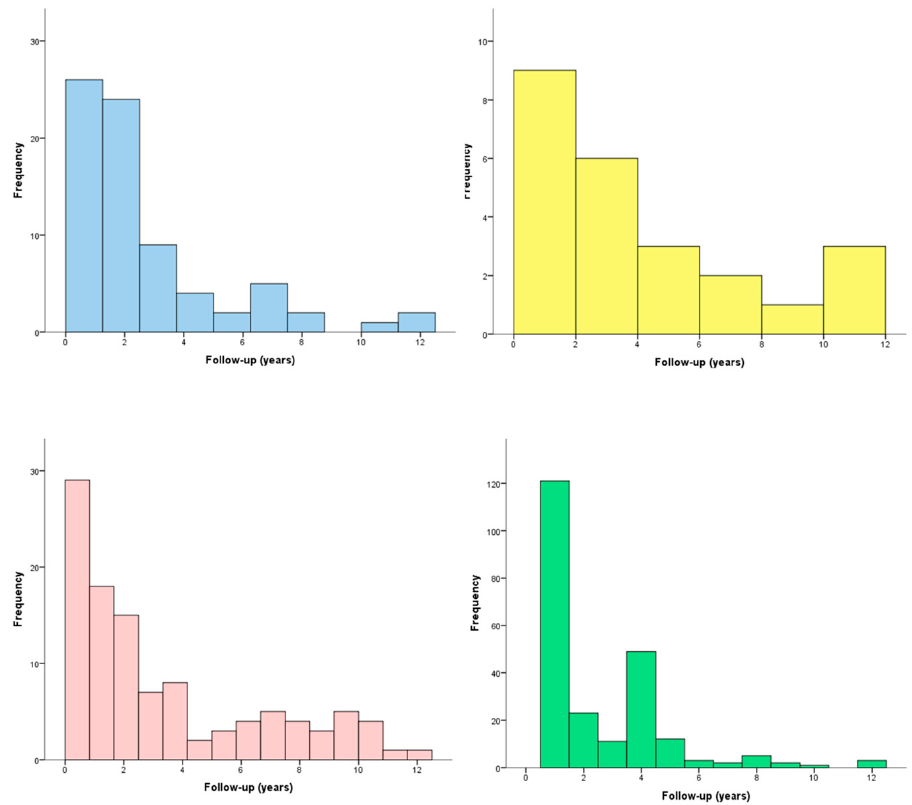
Figure 2. Time to occurrence of various events during follow-up of celiac patients, including irritable bowel syndrome-like symptoms (blue), gastroesophageal reflux disease-like manifestations (yellow), metabolic alterations (red), and osteoporosis